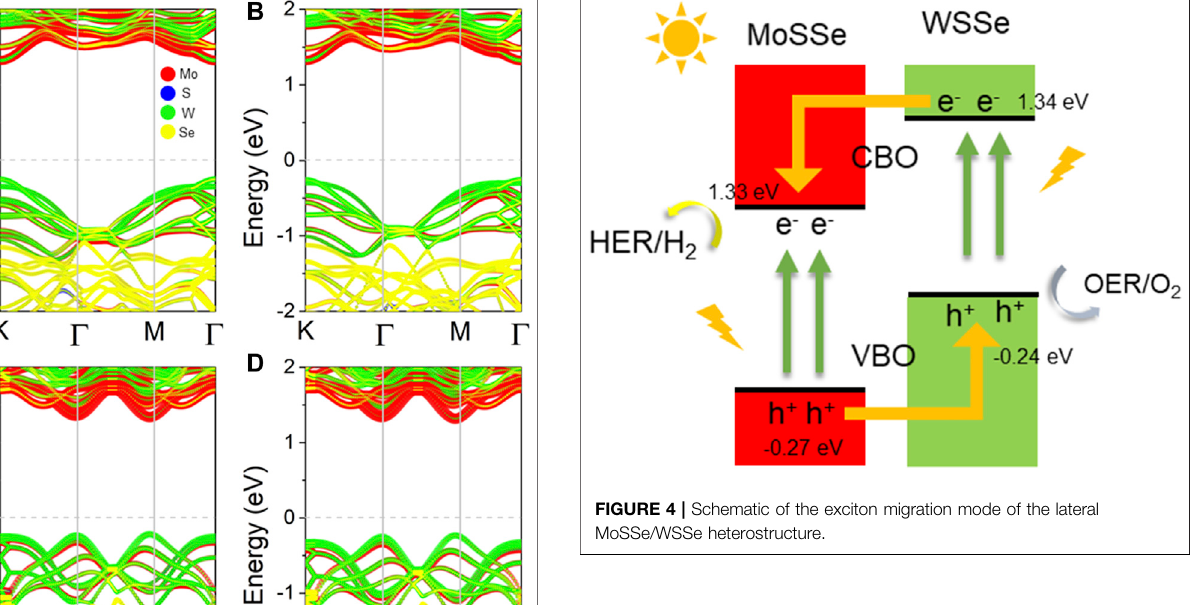
Frontiers in Materials |